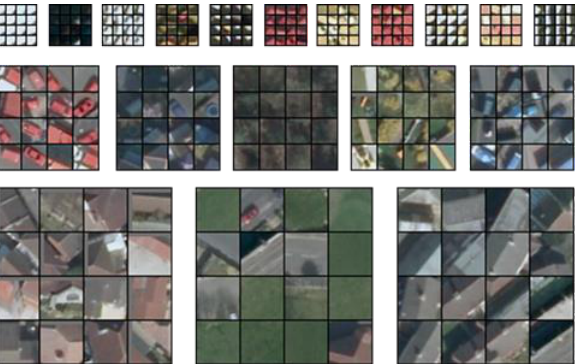
Figure 3. Examples of node responses within a CNN trained with aerial imagery. Each of the 19 squares contains the top 16 image clips that caused the highest activation of a given node within the network. Top Row : The 11 smallest squares are from one of the earliest activation layers in the network and demonstrate how early layers respond to edge features within the imagery. Middle Row : These 5 squares from a middle layer within the network, and apparently respond to specific colours. Bottom Row : This row shows how nodes may demonstrate more ‘semantic’ responses such as roofs and